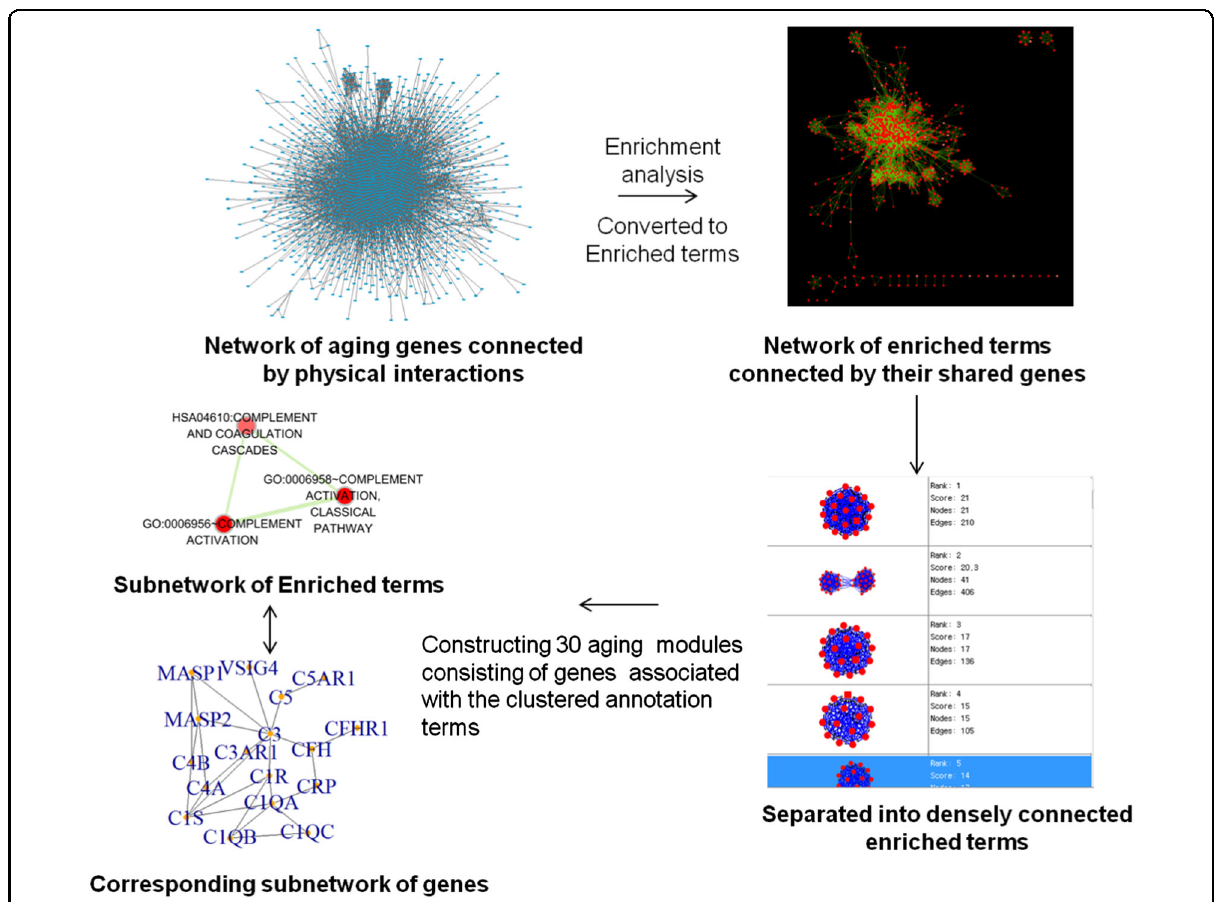
Fig. 1 Work fl ow for constructing functional association networks of aging genes. Our analysis was performed on aging genes forming the largest connected component (LCC) in the interactome. The LCC was subjected to gene ontology biological processes (GOBP) and KEGG enrichment analysis. Enriched terms were connected with each other according to their shared genes to generate an enrichment map which was separated into densely connected enriched terms. As a result, 30 aging modules were created. The terms were mapped to the corresponding genes, most of which are physically connected with each other within each aging